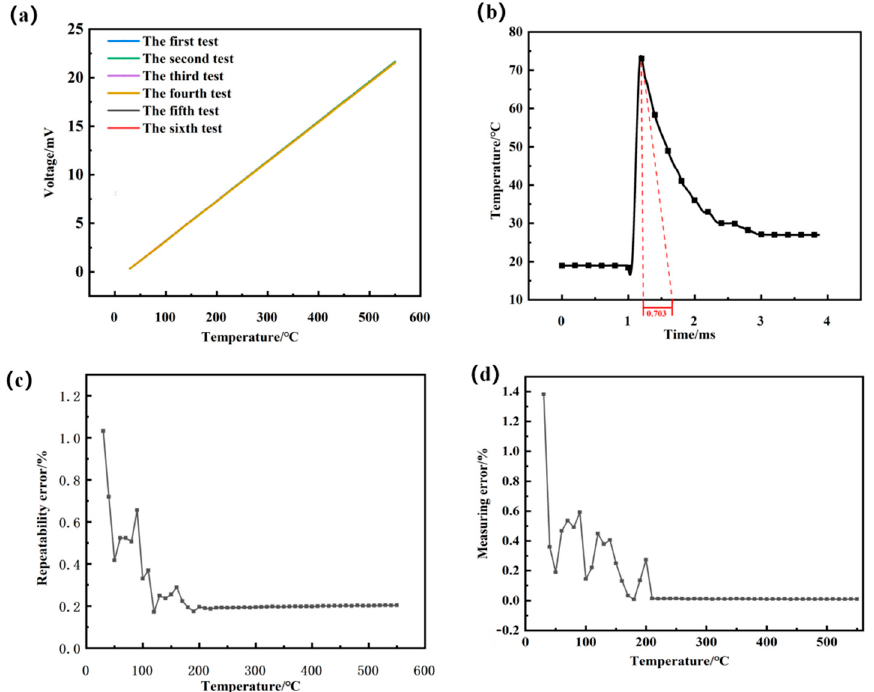
Figure 9. ( a ) Repeatability calibration curve for the thin-film thermocouple temperature sensor. ( b ) Dynamic calibration curve for the thin-film thermocouple temperature measurement blade. ( c ) Repeatability error curve. ( d ) Measurement error curve.